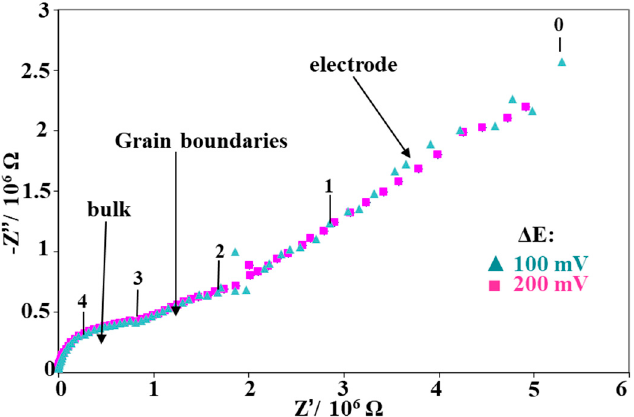
Figure 5. Nyquist impedance plots of the GDC09 coating, registered at 400 °C, for two a.c. signal amplitudes. The numbers 0, 1, 2, 3, and 4 correspond to the logarithm of the frequency value imposed during the impedance test.